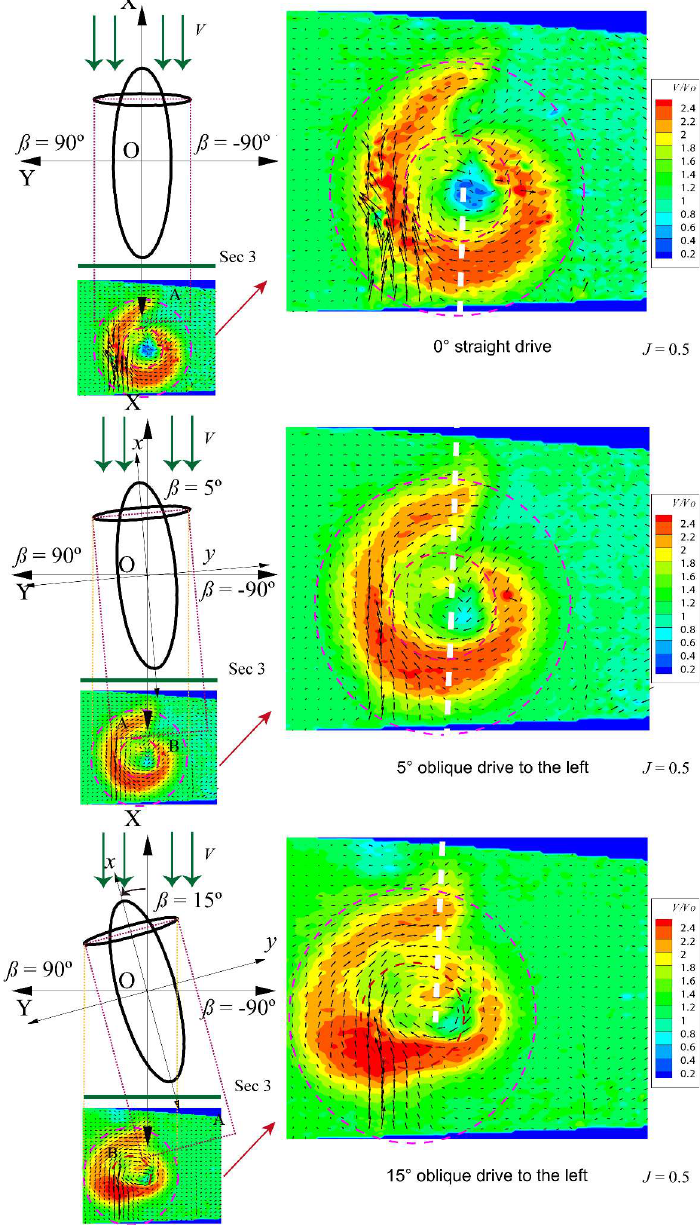
Figure 10. PIV measurements of the L-type podded propulsor at small rudder angles ( 𝐽 = 0.5).